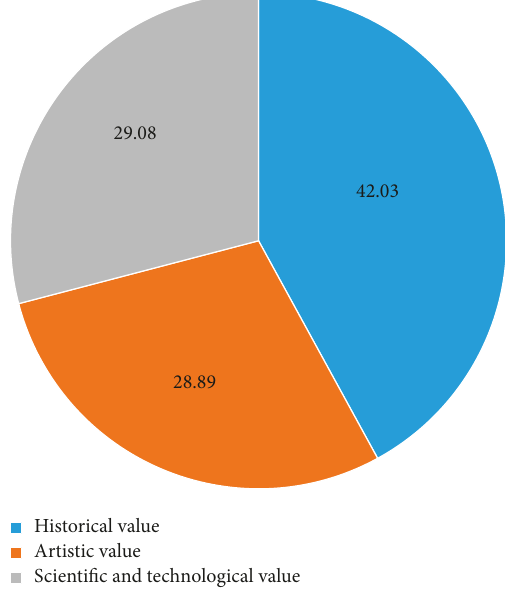
Figure 2: Analysis of the background value of the Dunhuang